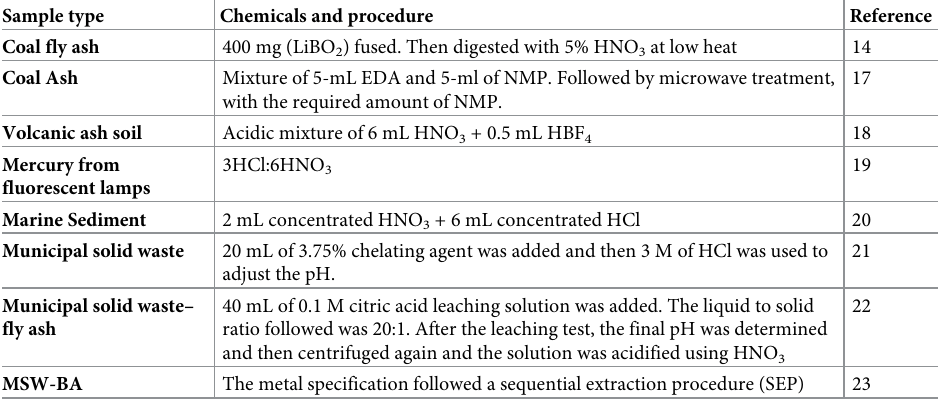
Table 1. Different experimental conditions used for metal extraction from solid